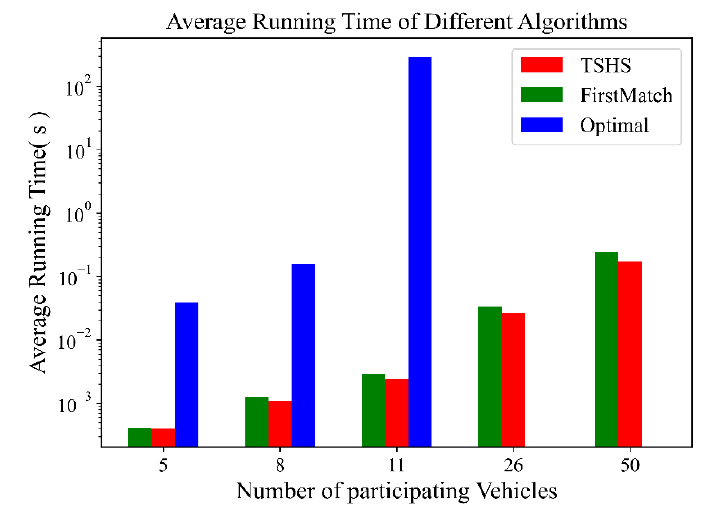
Figure 8. Average running time of different algorithms.